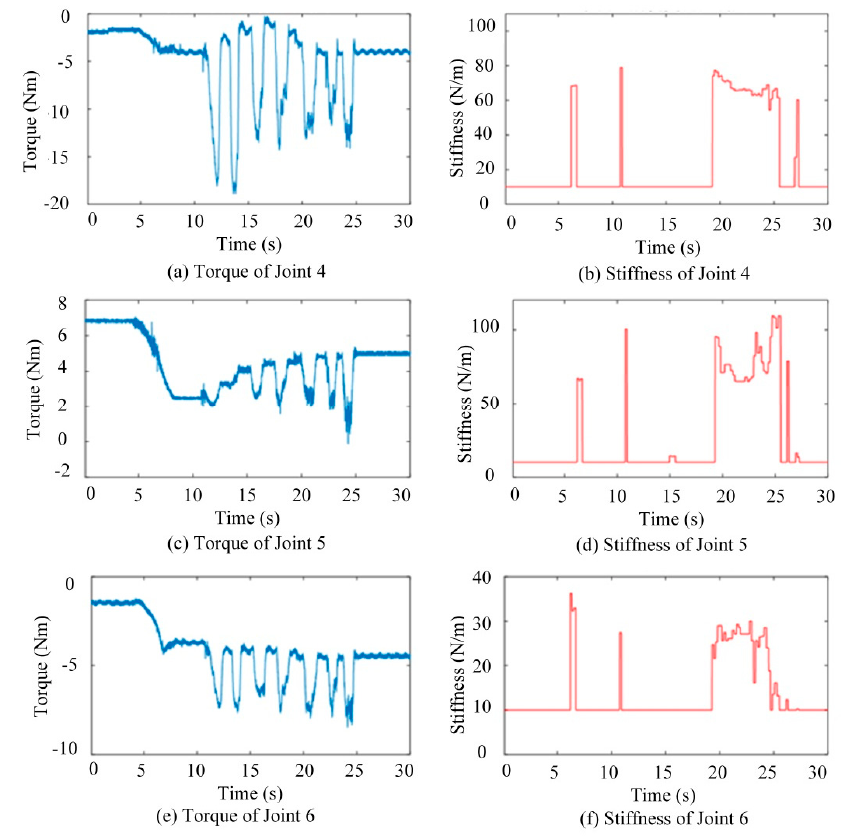
Figure 17. Experimental results of torque and stiffness.